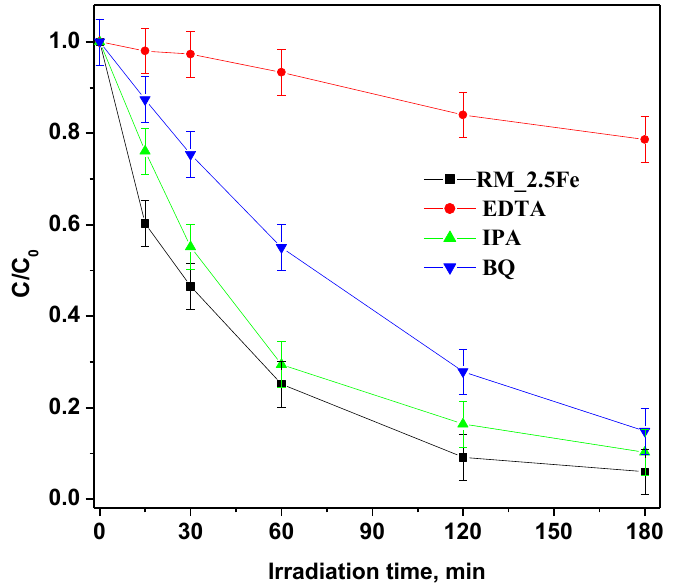
Figure 13. Effect of different scavenger molecules on the decolorization of CV aqueous solution using the RM_2.5Fe photocatalyst under visible (white) — light irradiation.